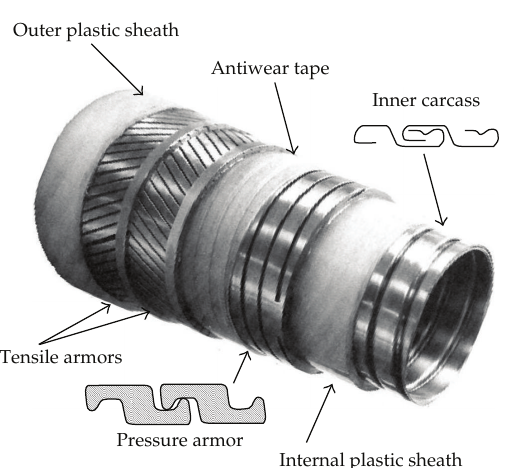
Figure 1: Typical unbonded flexible